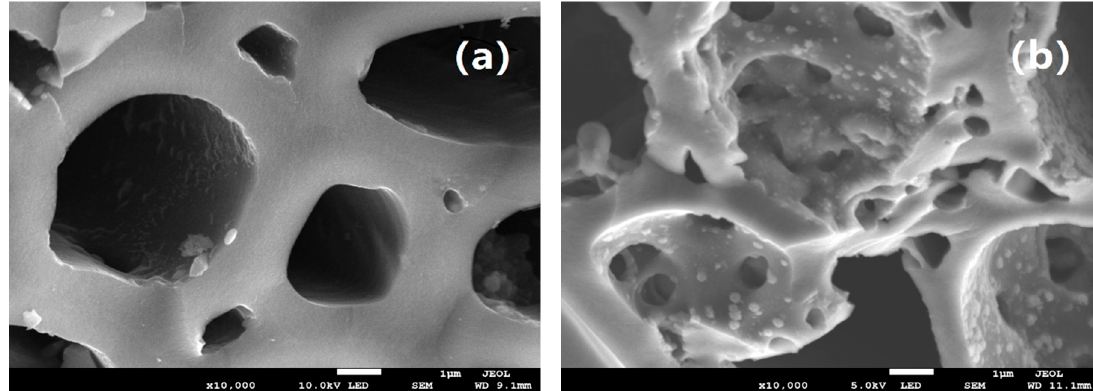
Figure 1. SEM image of mulberry stem biochar (MBC) and Fe-Mn binary oxide/mulberry stem biochar composite adsorbent (FM-MBC). ( a ) MBC, ( b ) FM-MBC.